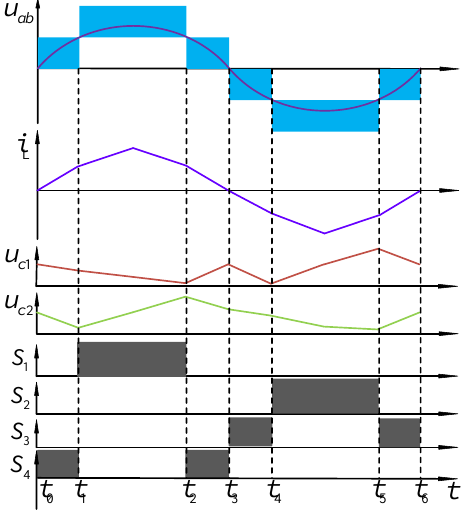
Figure 4. Current paths corresponding to six operating modes of the STL-PFC: ( a ) Mode 1 ( i L > 0, u ab = +0); ( b ) Mode 2 ( i L > 0, u ab = +0.5 u dc ); ( c ) Mode 3 ( i L > 0, u ab = + u dc ); ( d ) Mode 4 ( i L < 0, u ab = −0); ( e ) Mode 5 ( i L < 0, u ab = −0.5 u dc ); ( f ) Mode 6 ( i L < 0, u ab = − u dc ).